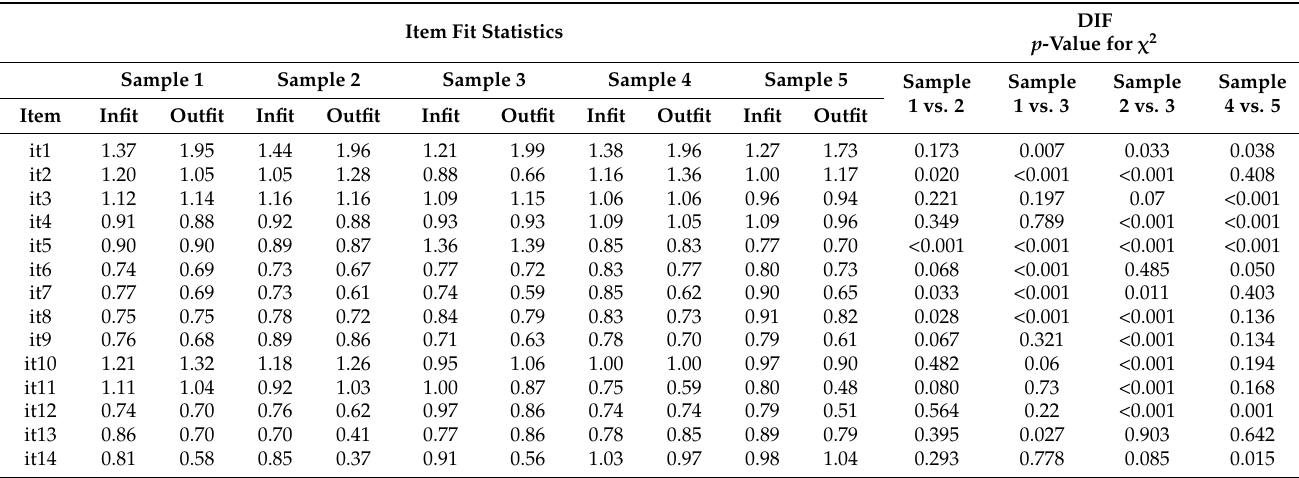
Table 4. Item fit statistics (information-weighted mean square [INFIT] and unweighted mean square [OUTFIT]) for each sample and Differential Item Functioning (DIF) analysis results between